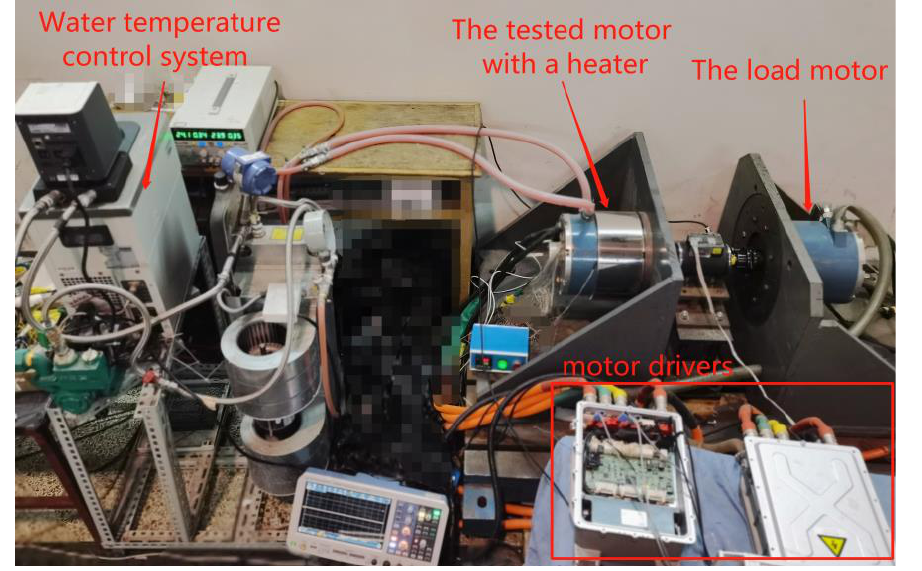
Figure 15. Field experimental environment. Table 2. Basic parameters of tested PMSM.